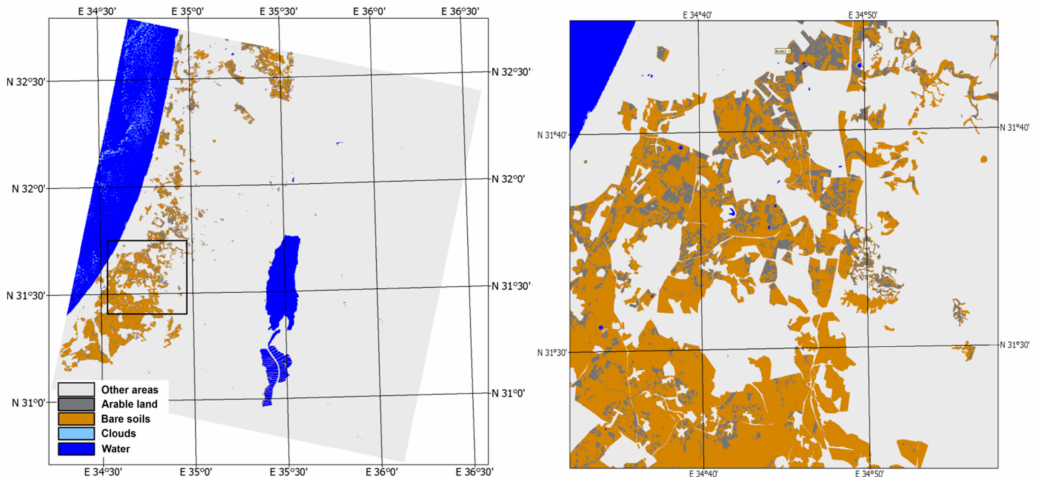
Figure 3. Bare soil areas extracted from Landsat 8 image in 174/38 scene, recorded on 23 August 2014 within arable land contours in